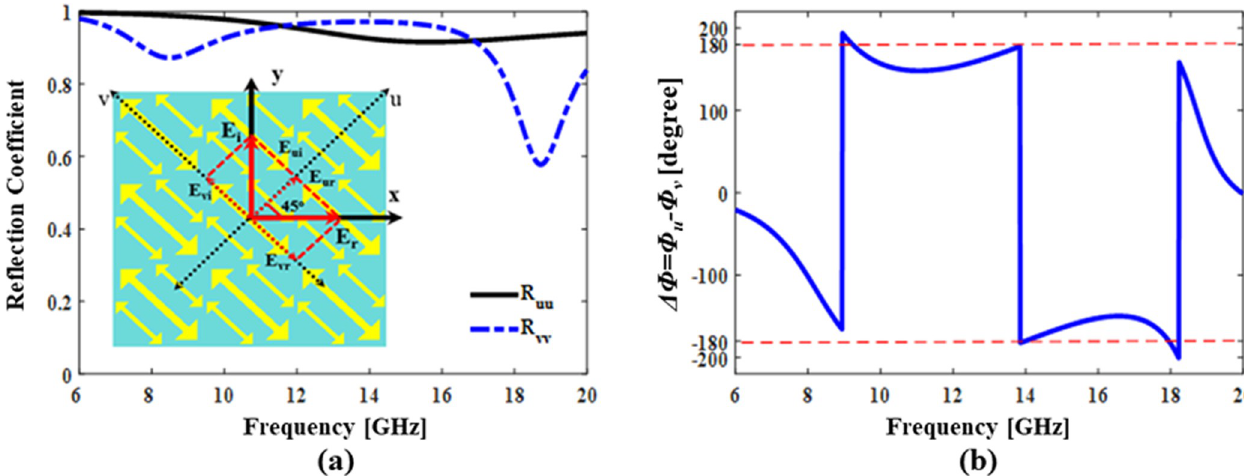
Fig 4. (a) Magnitude (in linear scale) of co-polarized reflection coefficients (R uu , R vv ) for u- and v-component waves (b) Phase difference (in degrees) between R uu and R vv